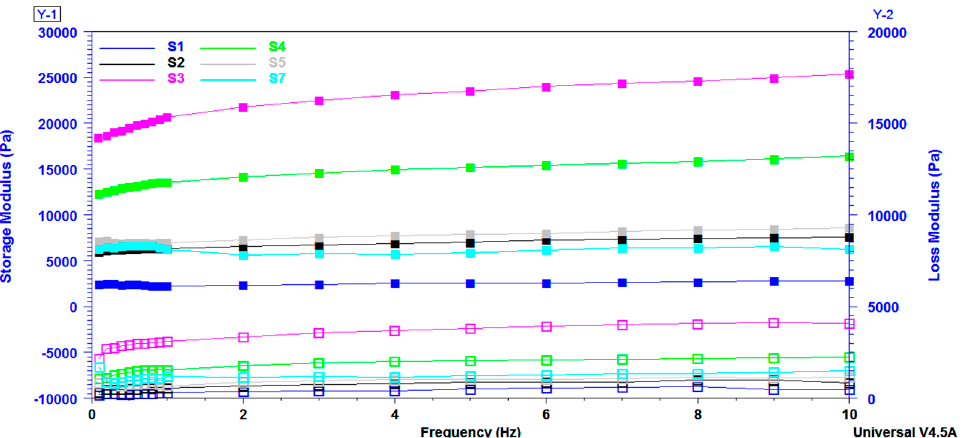
Figure 7. Storage modulus (G’) and loss modulus (G’’) as a function of frequency registered for salecan crosslinked hydrogels.